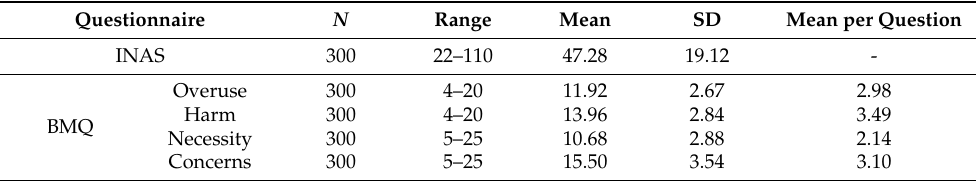
Table 2. INAS and BMQ questionnaire